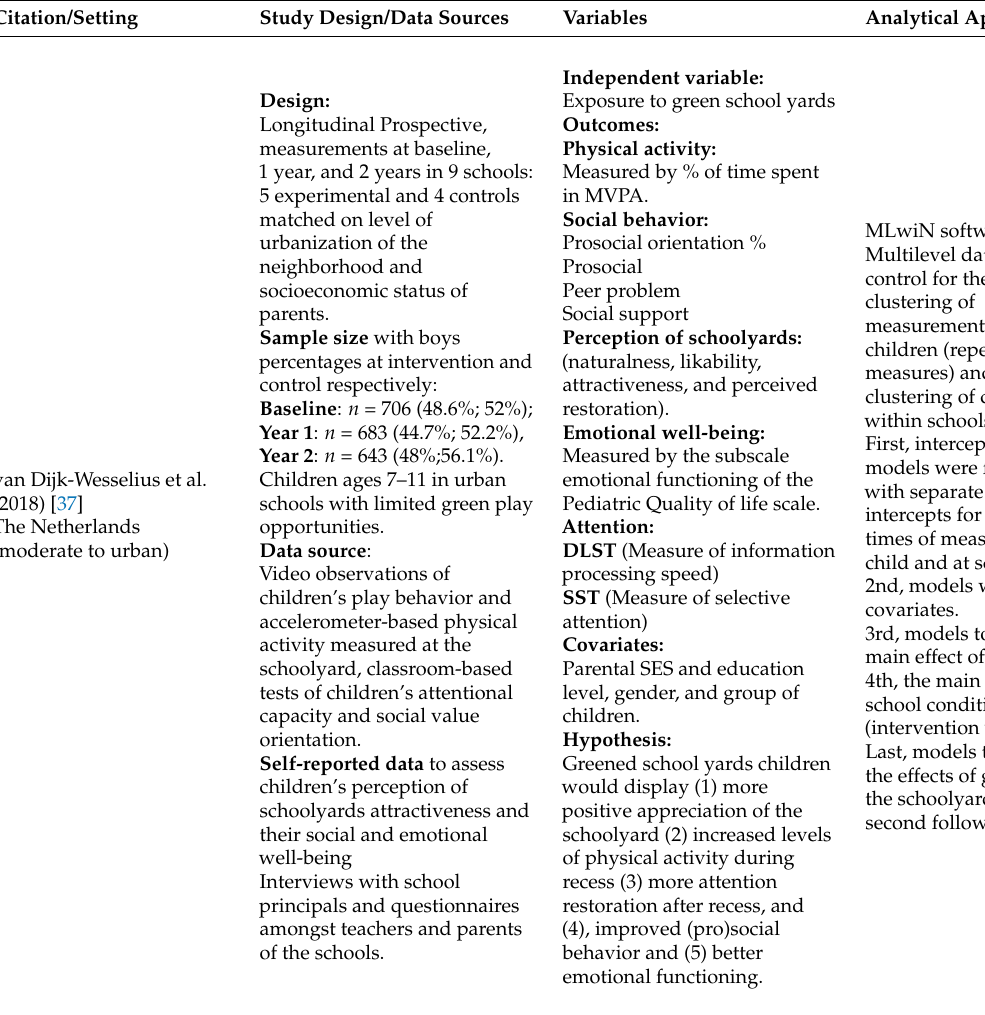
Table 1. Main characteristics and results of included